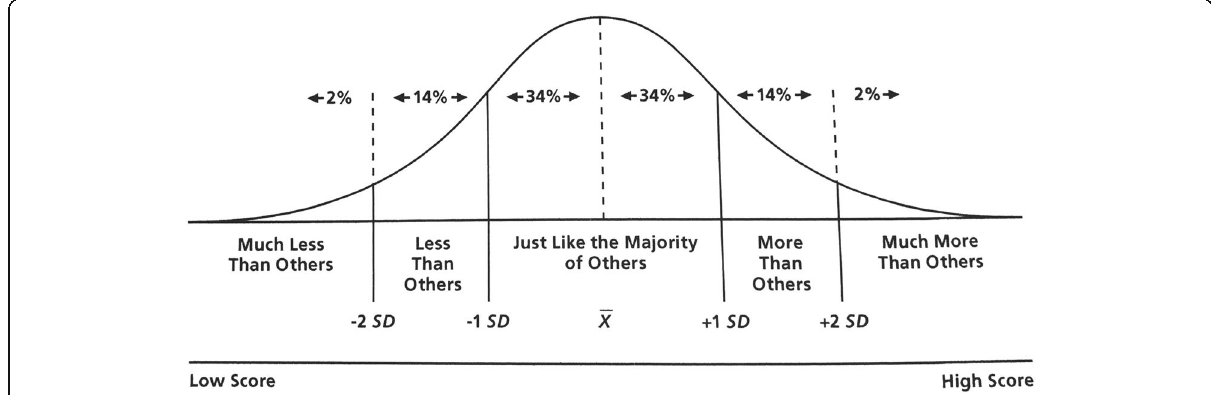
Fig. 1 The normal curve and the sensory profile 2 classification system (Dunn